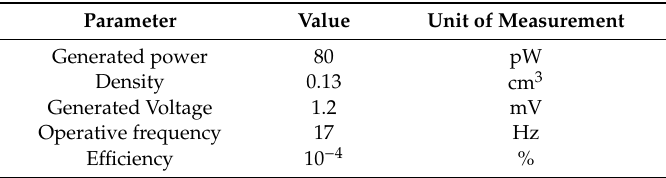
Table 2. Performance of the green energy harvester.